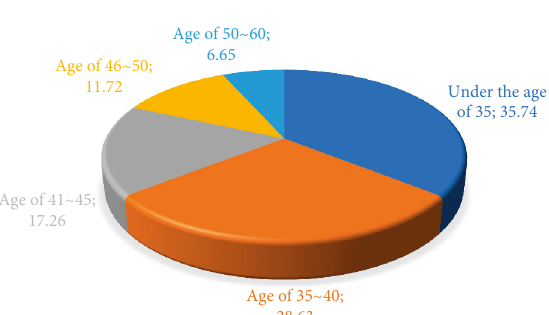
Figure 8: Enterprise employees’ age